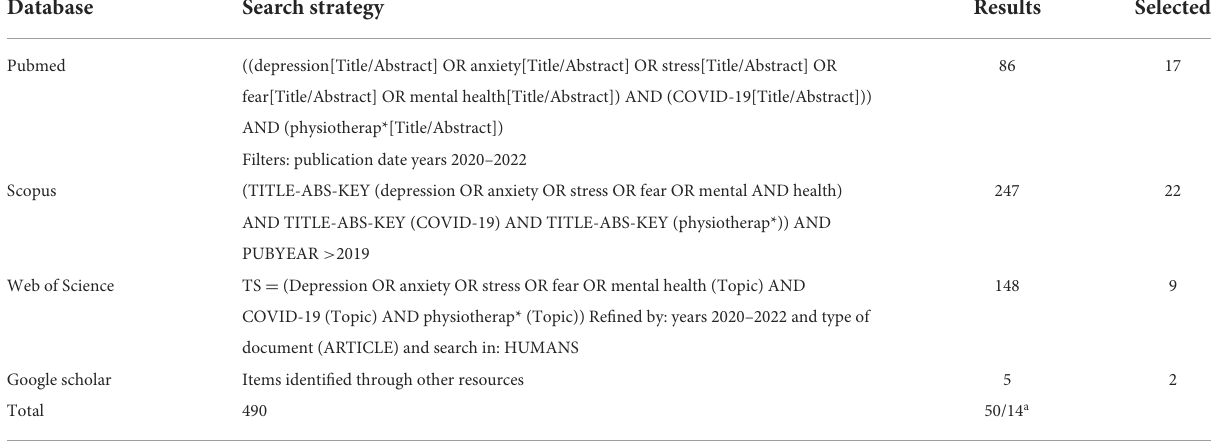
TABLE 3 Search strategy used by database (rehabilitation and COVID-19, Spain, 2022). Database Search strategy Results